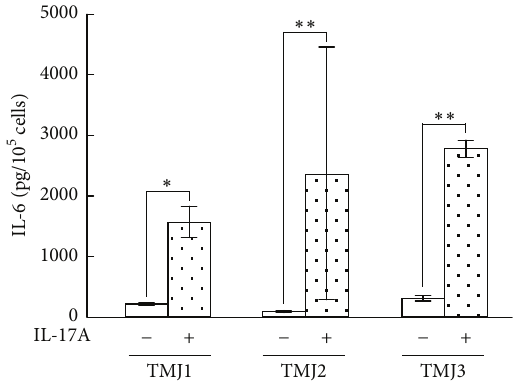
Figure 7: Effect of IL-17A on IL-6 production by three human synovialfibroblastsamples.Synovialfibroblastsampleswereisolated from three patients with TMD (TMJ1-3). The cells were treated with 10ng/mL IL-17A for 24 h, following which the IL-6 protein levels in the conditioned medium were then assayed using ELISA. Data are shown as means ± SD ( 𝑛 = 6 ); ∗ 𝑃 < 0.05 ; ∗∗ 𝑃 < 0.01 .